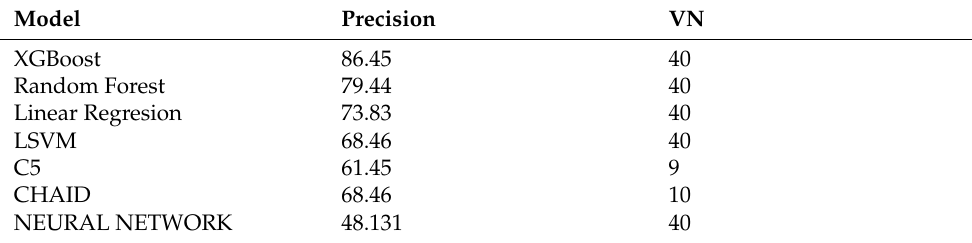
Table 2. Precision of the AI algorithms